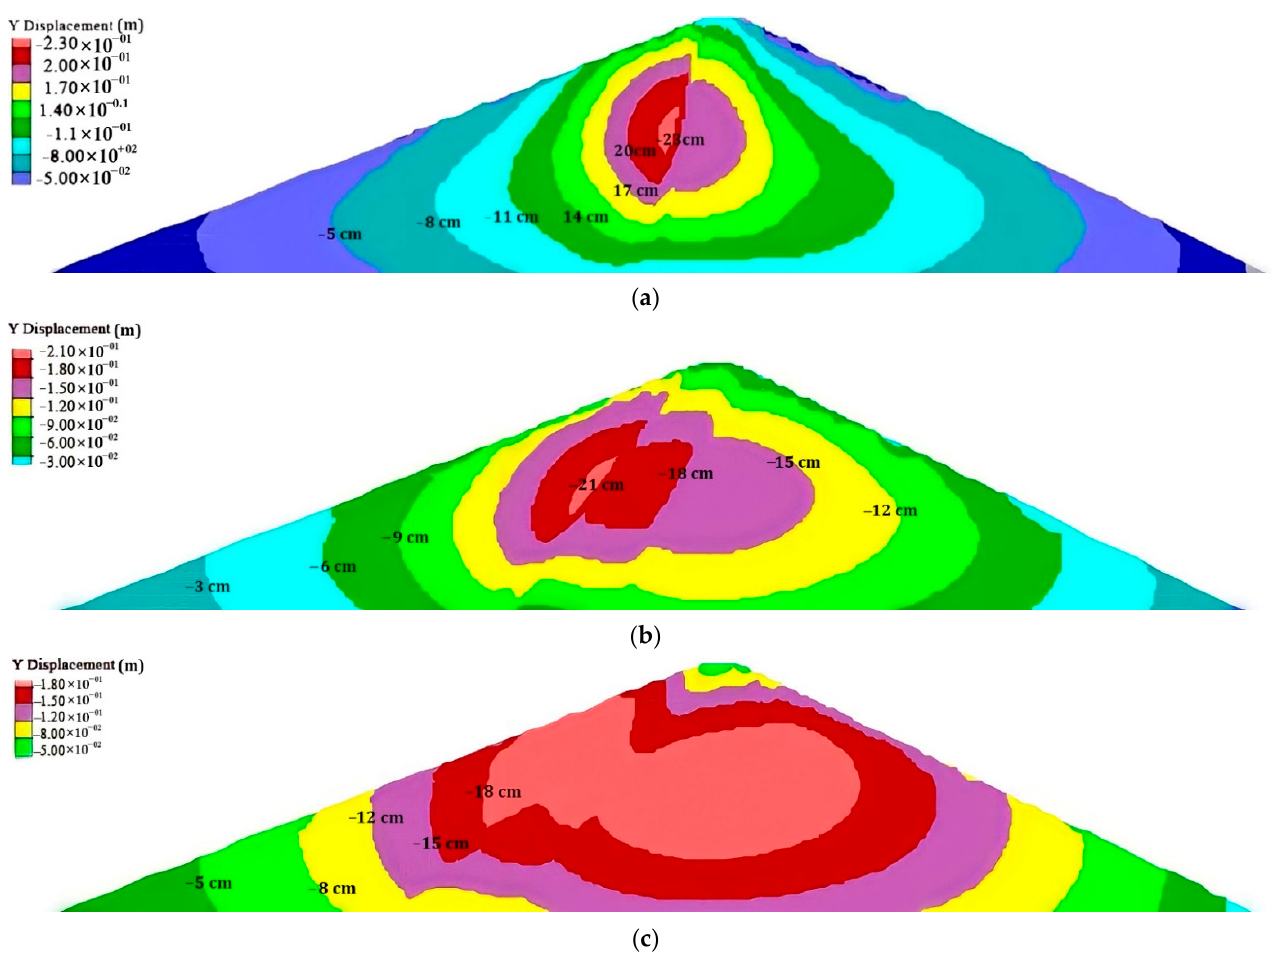
Figure 4. Settlement contours at impounding stage ( a ) 90° core, ( b ) 60° core and ( c ) 45° angled core.